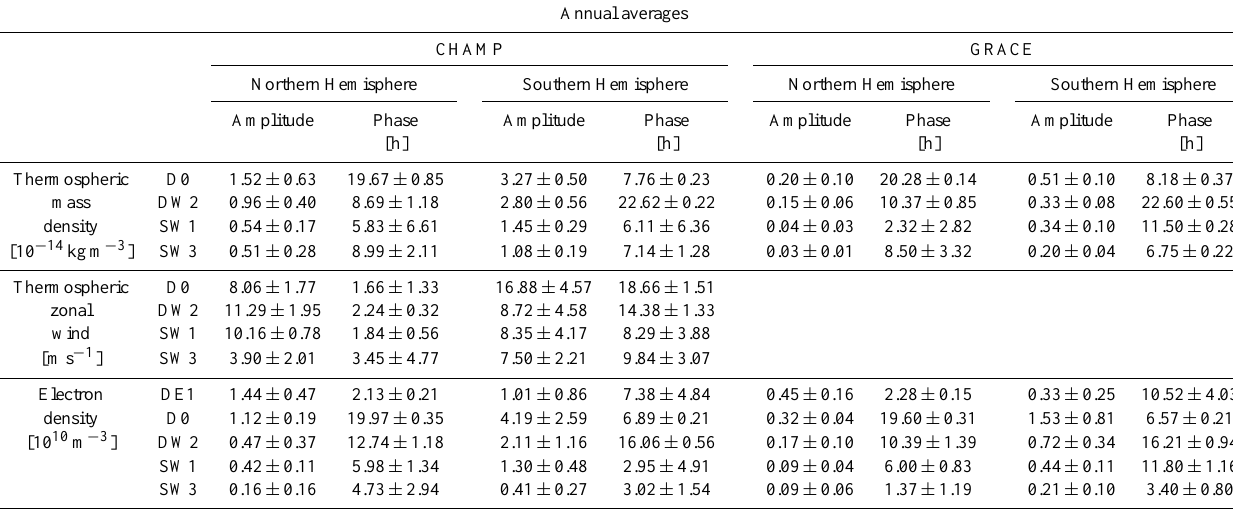
Table 4. Annual average values of the amplitudes and phases of the prominent diurnal and semidiurnal tides, in thermospheric mass density, zonal wind and electron